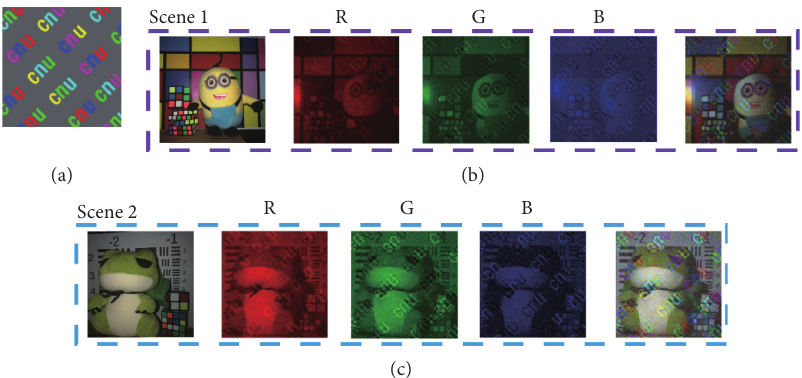
Figure 8: Complementary experimental results of color watermarking on 3D color scenes. (a) Color watermark pattern. The first images in (b) and (c) are the photos of the scene acquired using a smartphone; the other images are the imaging results of RGB channels and synthesized